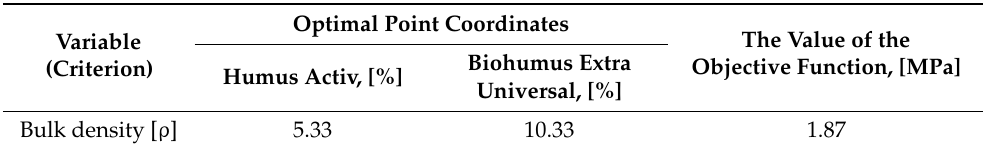
Table 6. Values of the studied factors at optimal points examined variable (bulk density) and the respective objective function.